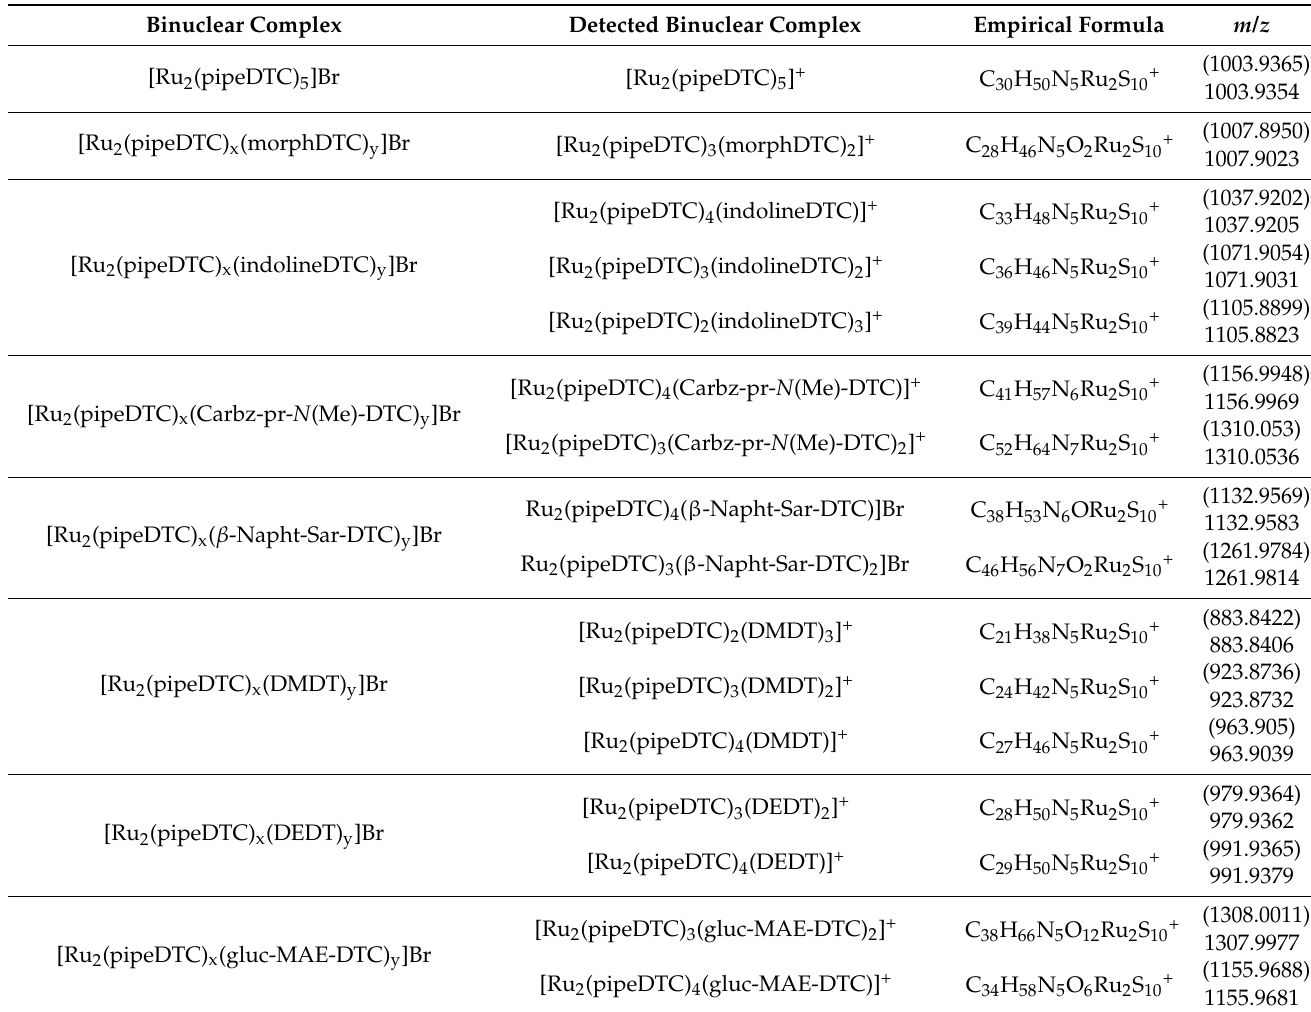
Table 1. ESI-MS signals for [Ru 2 (pipeDTC) 5 ]Br and the binuclear heteroleptic Ru(III)-DTC complexes synthesized from the bimetallic oxidized precursor. Calculated (in bracket) and experimental values are listed in the right column. Typically, most of the signals are accompanied by adducts with the